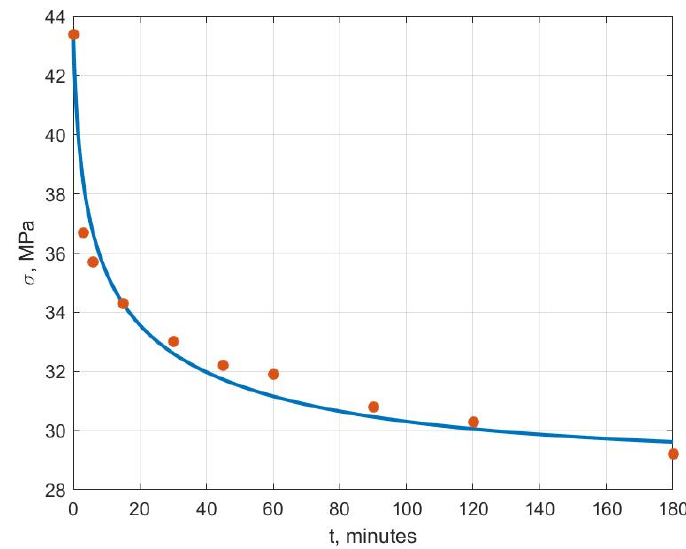
Figure 7. Stress relaxation curve at 𝑇 = 30 °C .